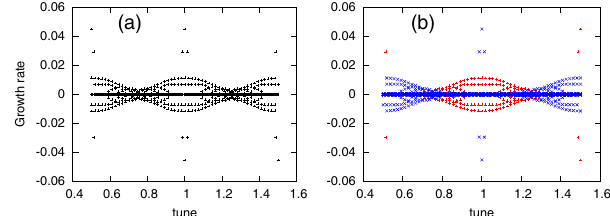
¼ 0 . 75 with the largest eigenvalue x ¼ 0 . 025 and θ ¼ 10 (FCCee-Z). x P